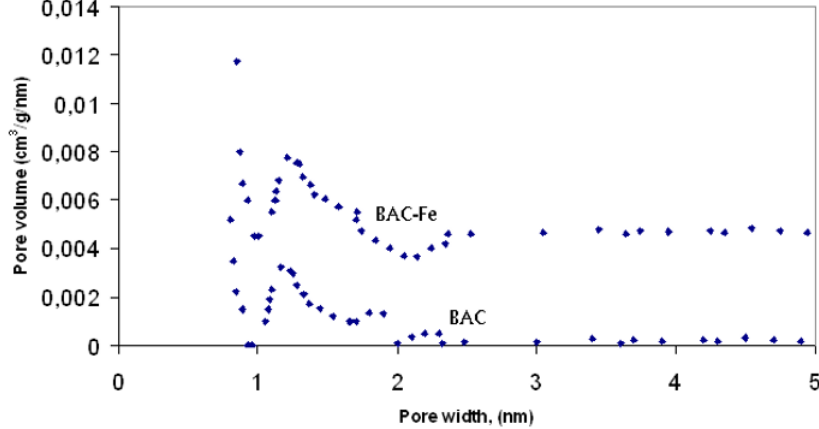
Figure 3. Pore size distribution for BAC and BAC-Fe carbons.